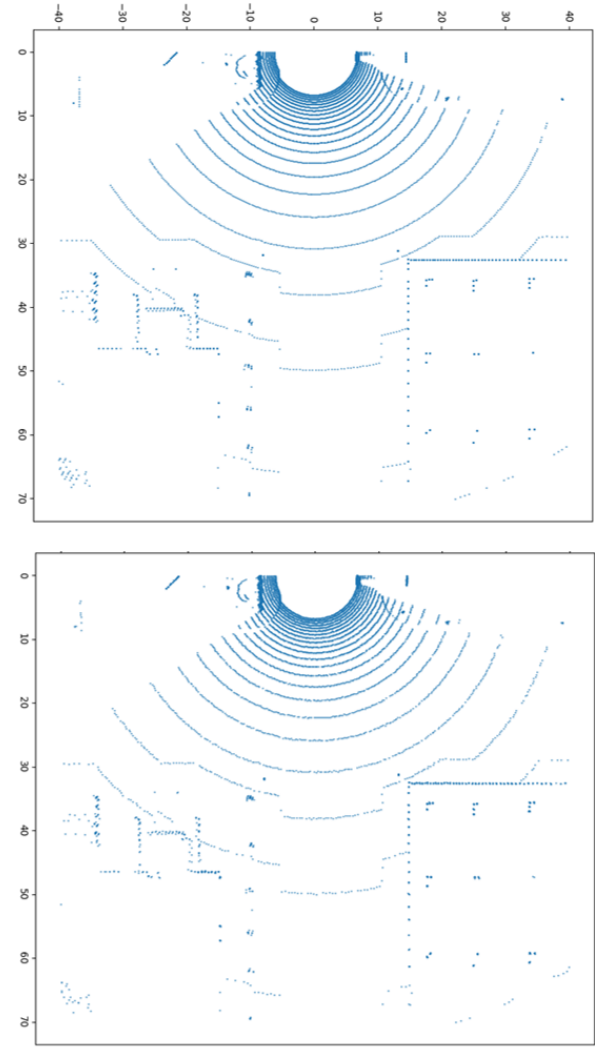
Figure 8. An example frame of point cloud data before and after adding sensor noise (only points in the front half-circle of the vehicle is